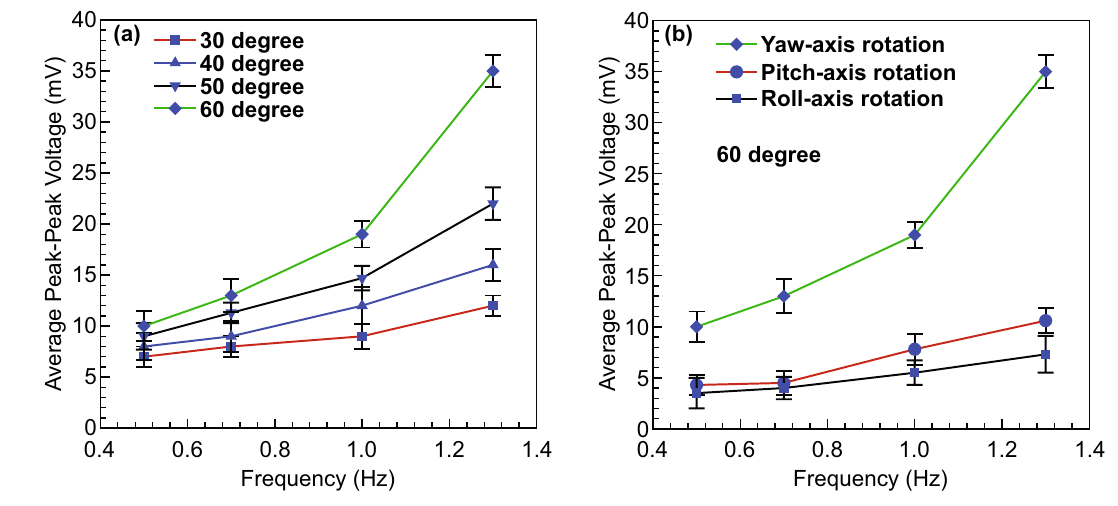
Fig. 7 a Sensor response to various rotational angles and frequencies in yaw axis rotation and b changes in rotational axes